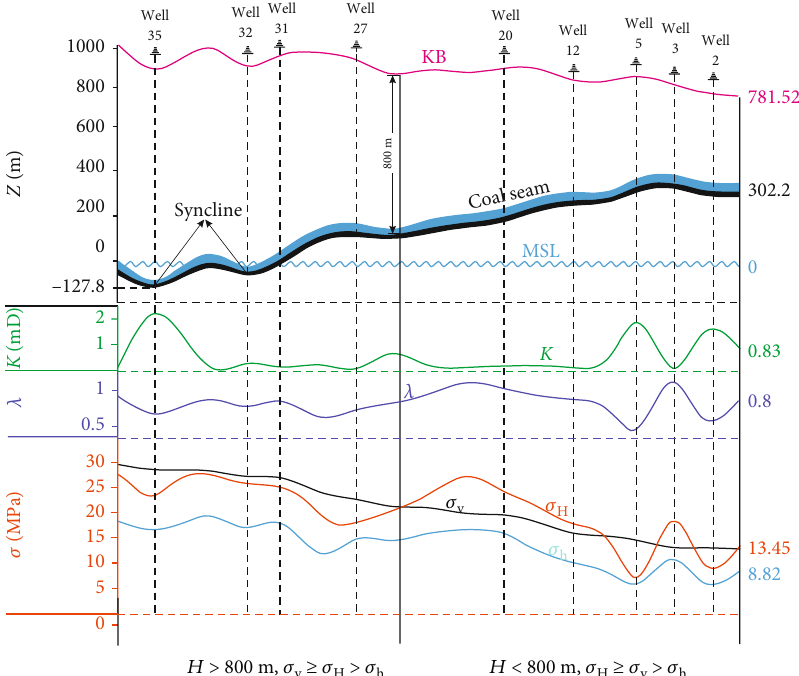
Figure 11: Variation trend of each parameter in di ff erent depth zones. Z : represents altitude, m; KB: represents the kelly bushing; MSL: represents mean sea